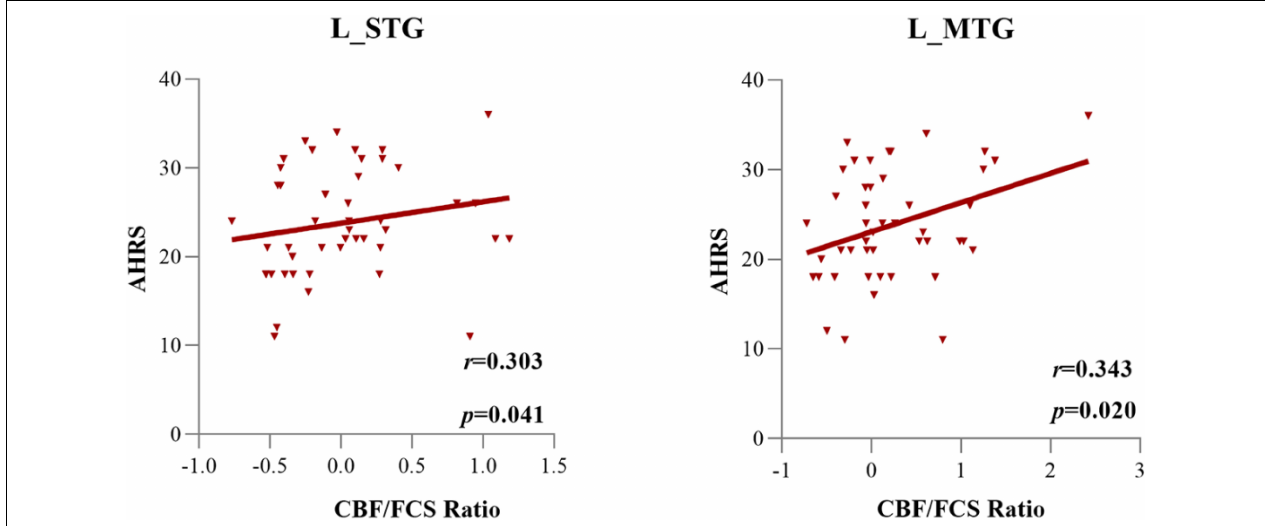
FIGURE 5 | The cerebral blood flow/functional connectivity strength (CBF/FCS) ratio of the left STG and left MTG was positively correlated with the severity of auditory verbal hallucinations, as assessed by AHRS scores in AVH